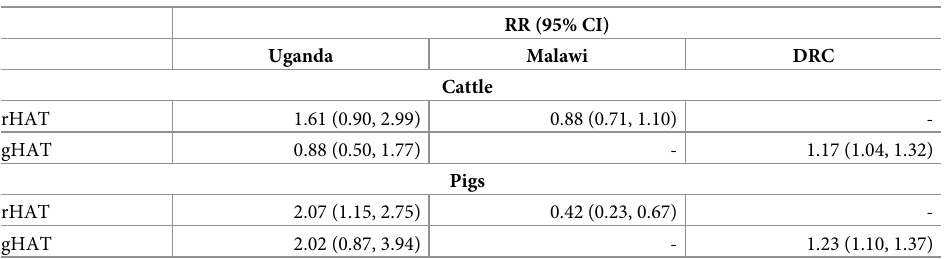
Table 3. Parametric g-formula results.